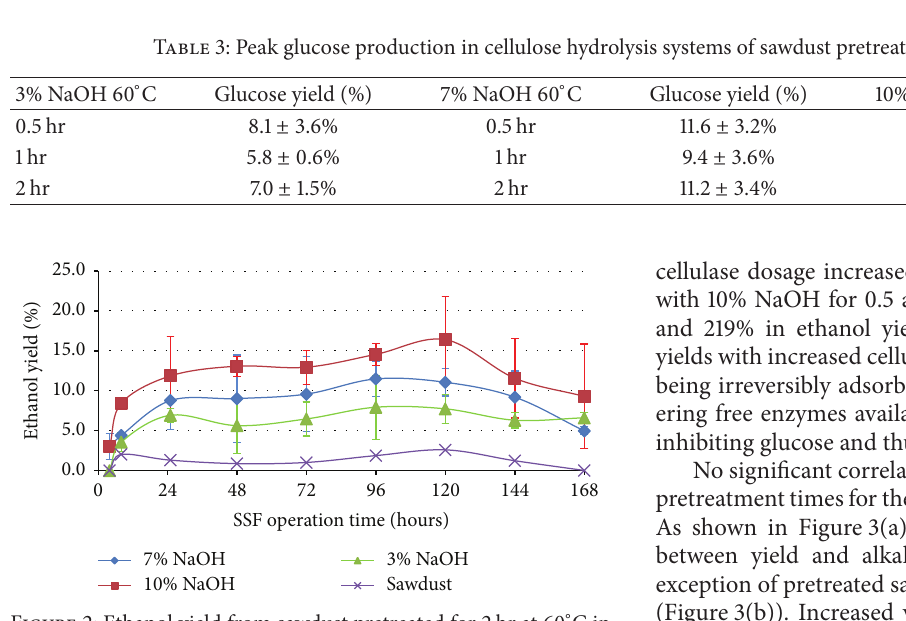
Figure 2: Ethanol yield from sawdust pretreated for 2 hr at 60 ∘ C in NaOH solution, with 20 FPU / g TS